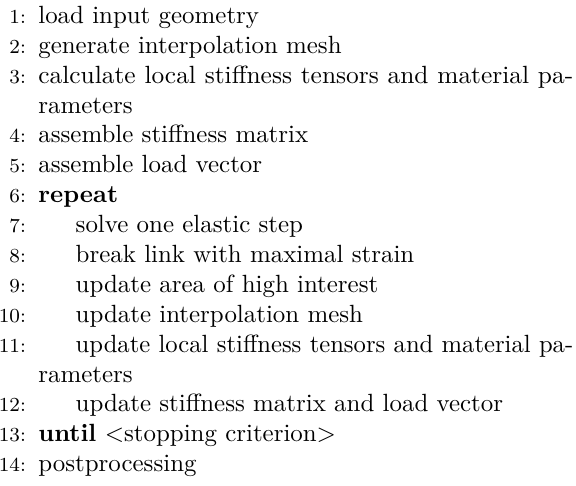
Algorithm 1 Adaptive QC